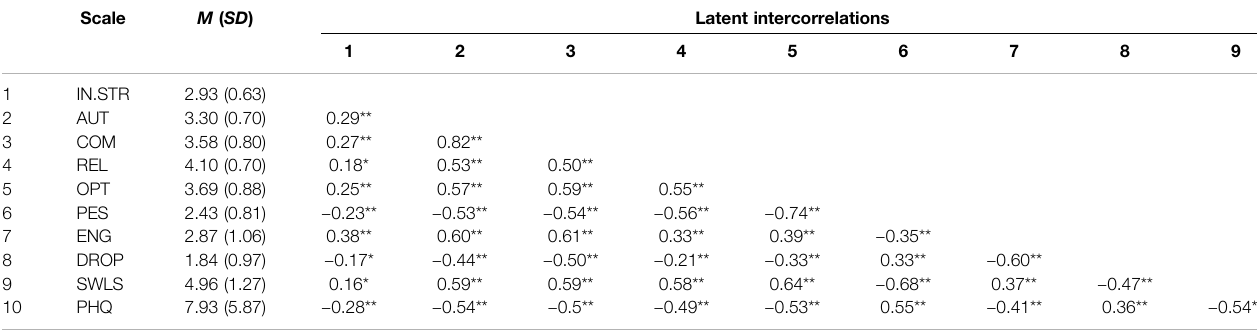
TABLE 1 | Mean values, standardized deviations, and latent intercorrelations.